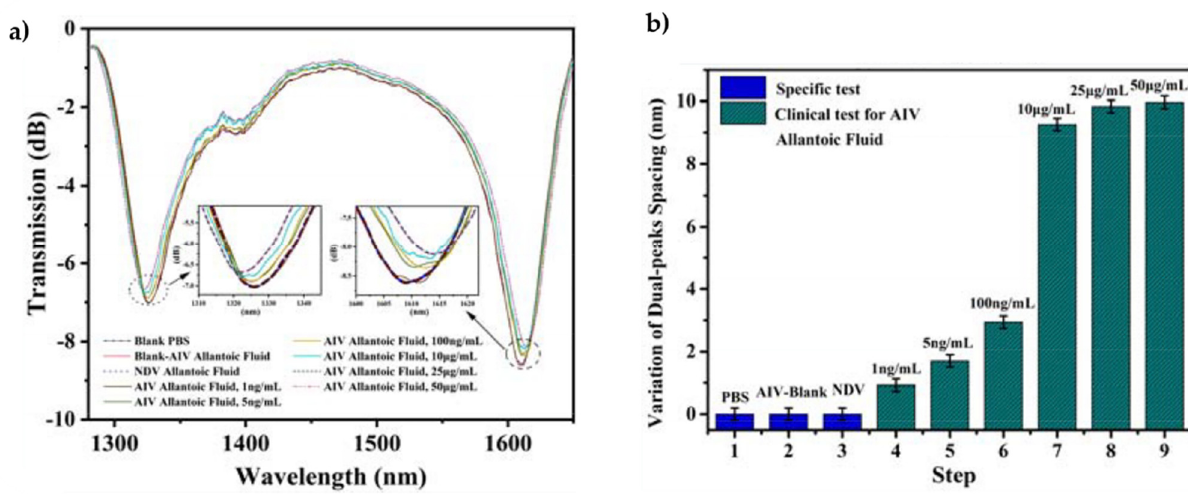
Figure 12. GO-modified turning point LPG for immunodetection of H5N1 virus: ( a ) spectral evolution, the dual-peak movements are magnified in the inset, and ( b ) variations of the dual-peak spacing during the specific tests: PBS, avian influenza virus (AIV) blank and NDV, as well as the clinical tests which consists in AIV allantoic fluid with different concentrations of H5N1 virus. Reprinted with permission from ref. [119]. Copyright 2020 John Wiley & Sons, Inc., Hoboken, NJ, USA.